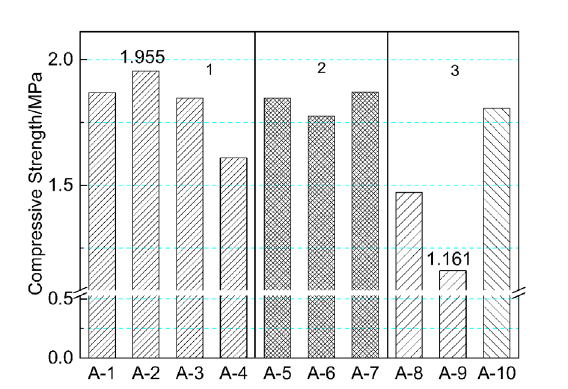
Figure 3: The compressive strength of